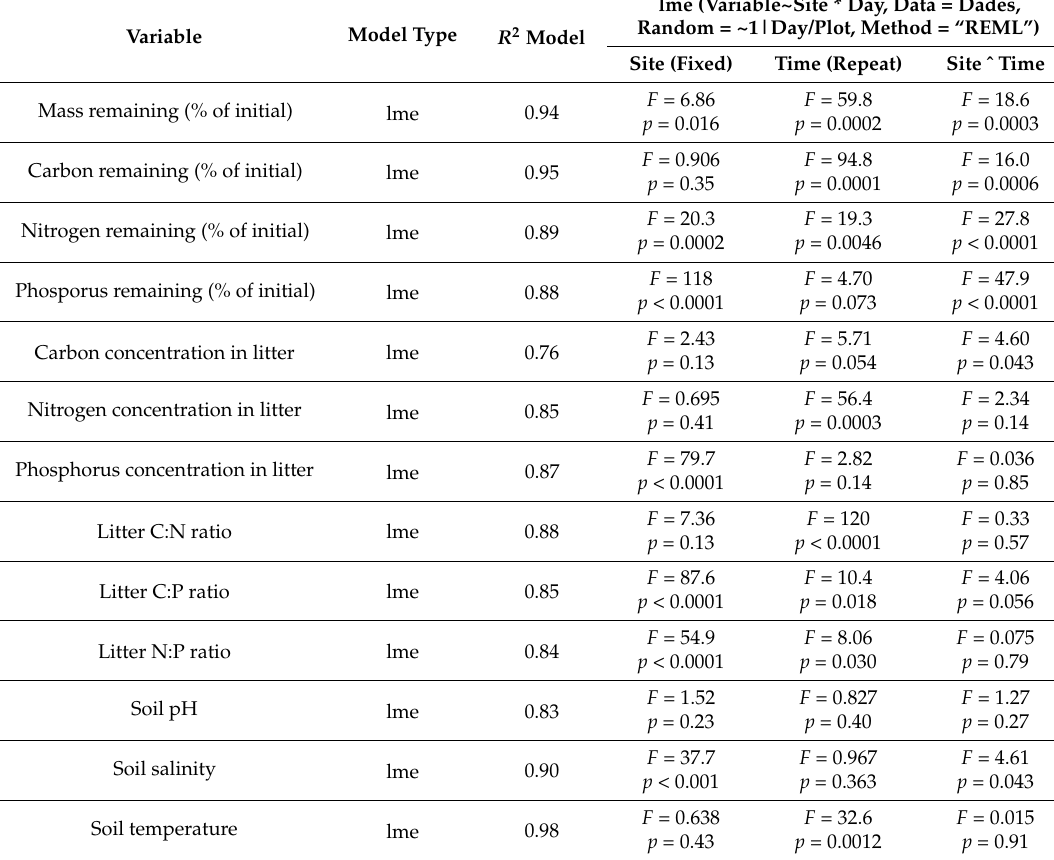
Table A1. Results of the mixed repeated measures (time) models with habitat (ridges versus ditches) as the fixed independent variable, plot the as random variable, and the different litter and soil studied